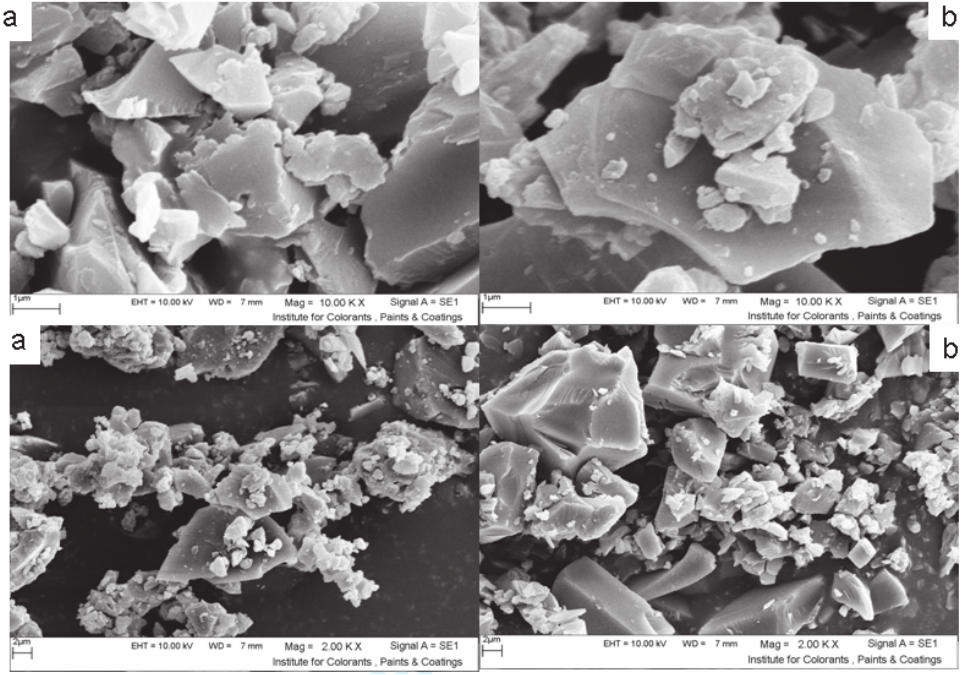
Figure 3. Scanning electron micrographs of PA-nanocomposite films 3a (a) and 3b (b) .